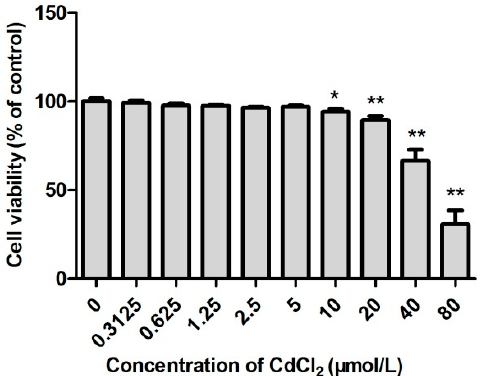
Figure 1. Effect of cadmium on the survival rate of TM3 cells. * and ** represent a significant and an extremely significant difference, respectively, compared with the control group.